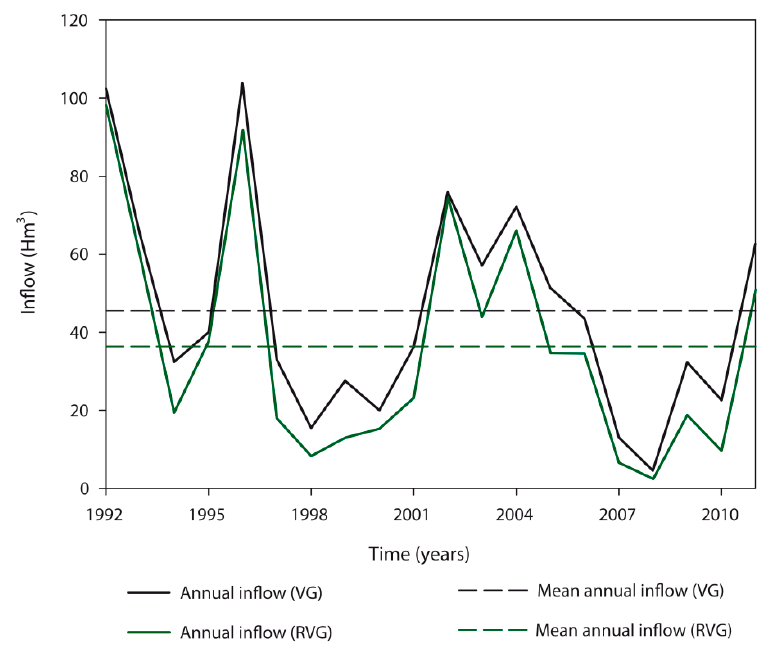
Figure 8. Simulated annual inflow with actual land use (VG) (in black) and with land-use change scenario (RVG) (in green).